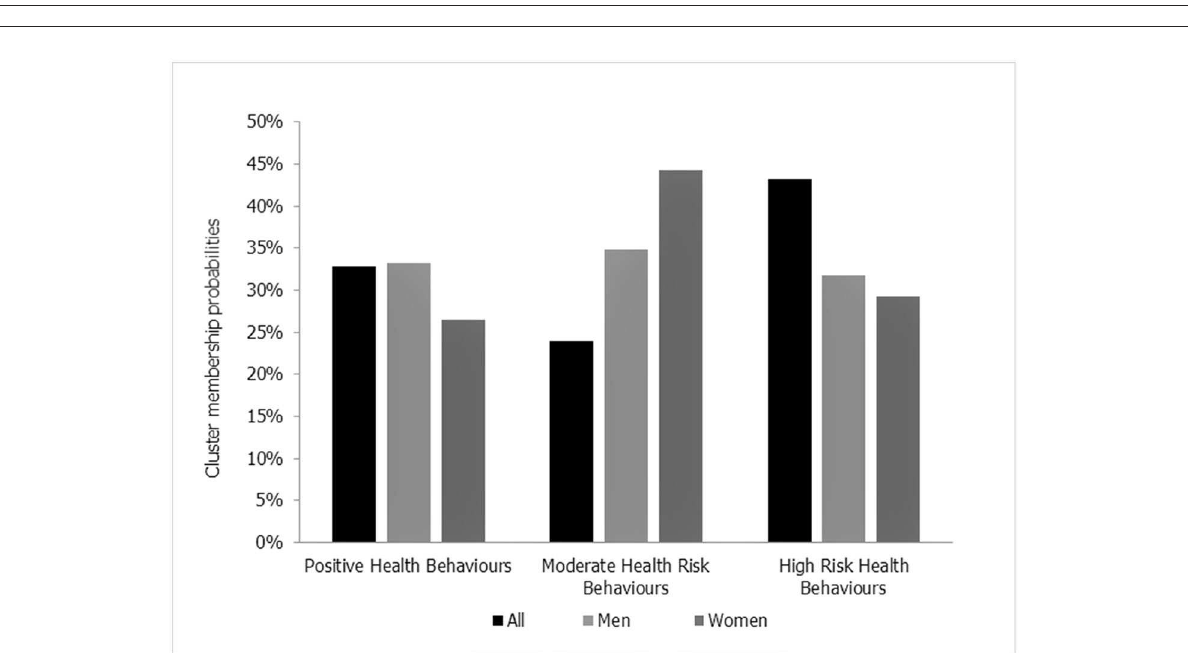
FIGURE3 Cluster membership probabilities for the total population and by